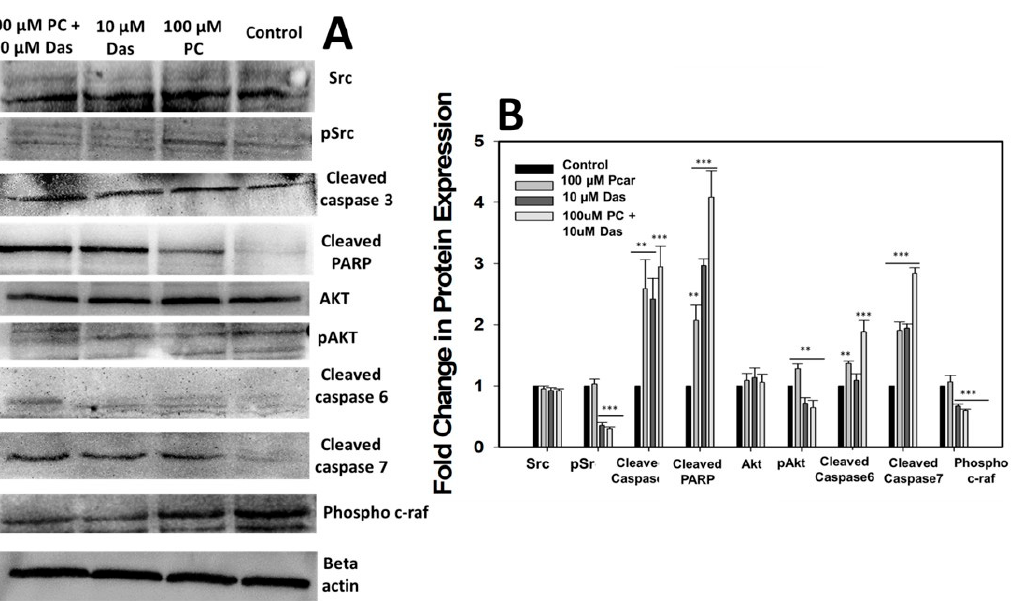
Figure 7. ( A ) Western blot analysis showing the expression of several proteins involved in signaling pathways involved in cancer. ( B ) Quantitative estimation of protein expression. Data expressed as mean ± standard error (SE) calculated from three ( n = 3) independent experiments, ** p < 0.01, *** p < 0.001.